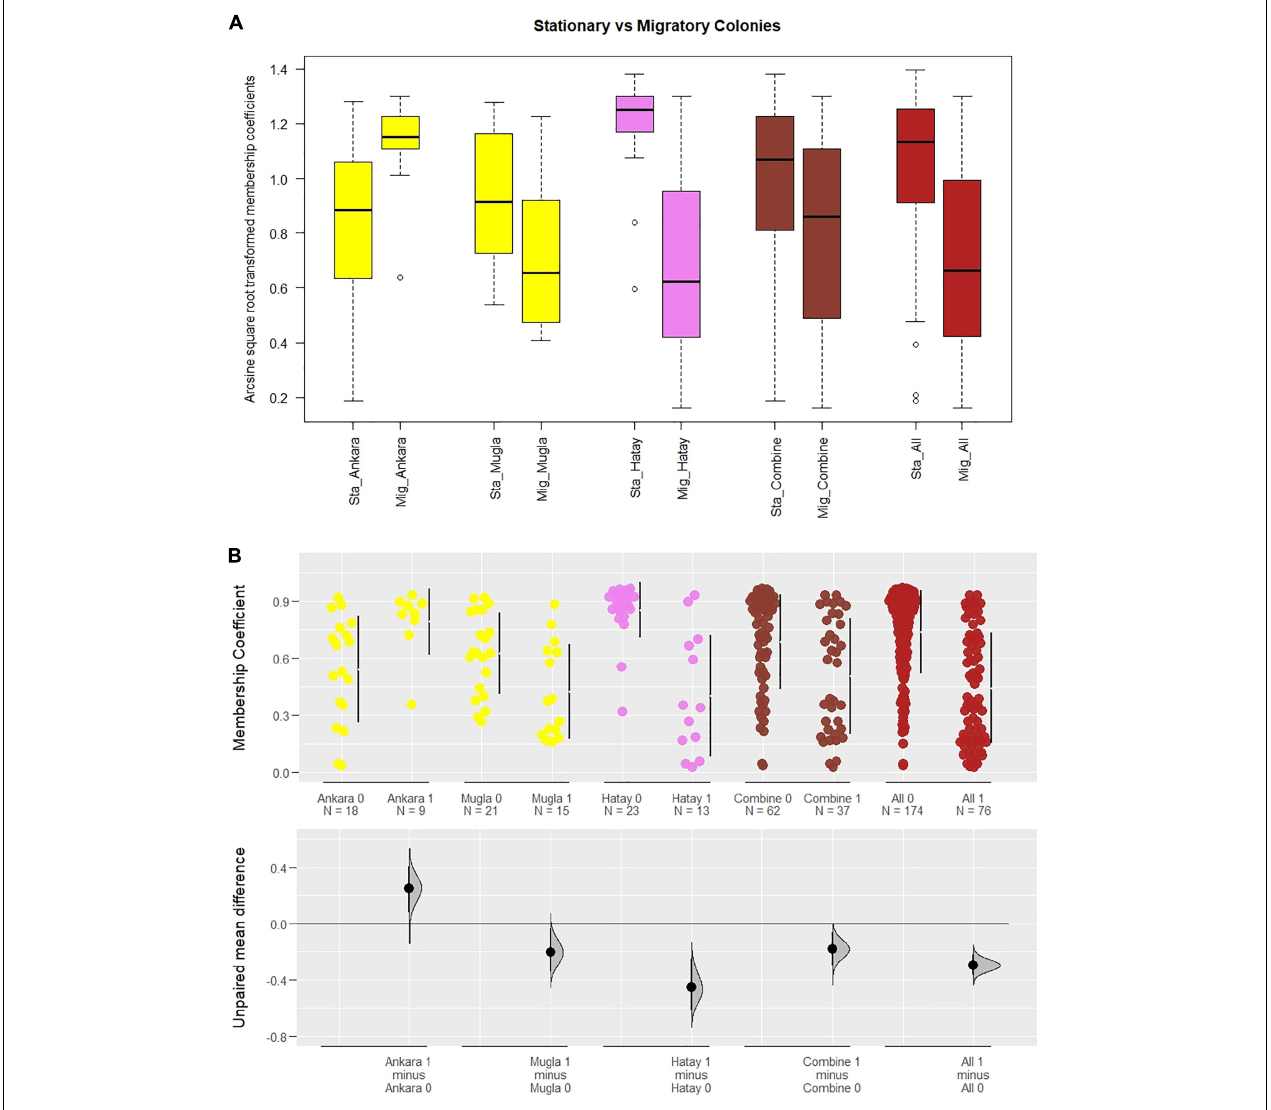
FIGURE 4 | Comparison between stationary (Sta_) and migratory (Mig_) colonies in Ankara ( p < 0.05), Mu˘gla ( p < 0.05), and Hatay ( p < 0.001), as well as these three provinces combined ( p < 0.01) and the whole data set ( p < 0.001). (A) Boxplot display of arcsine square-root transformed membership coefficients used in significance testing of comparisons. (B) Scatter plot with estimations of mean differences based on raw individual membership coefficients (yellow: Ankara and Mu˘gla belonging to the Anatolian cluster, violet: Levantine cluster, coral: for a combination of three provinces, firebrick: whole data). Stationary colonies are annotated as < Group name > 0 and migratory colonies as < Group name > 1. Bars right to the data points refer to the 25 and 75% quartiles and the gap between them is the median value for the sample. The zero-line below corresponds to the mean membership coefficients of stationary colonies in each pairwise comparison. The Euclidean distances from those means for the migratory colonies are shown as dots with a 95% confidence interval bar around. Also, distributions of the estimation statistics are included to comprehensively compare the strength of the drift for different populations and subsets of the data. Stationary colonies exhibit higher mean membership coefficients than migratory ones except for Ankara where the vice versa is